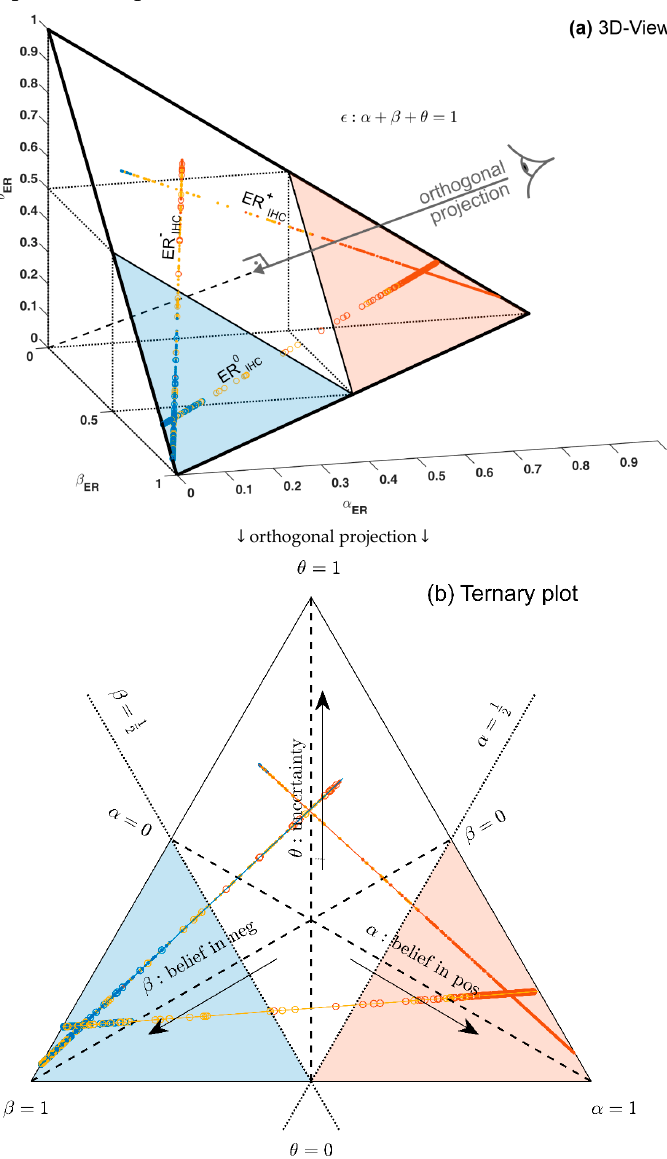
Figure 4. 3D plot and ternary plot of evidence for estrogen receptor status. ( a ) ordinary 3D plot. ( b ) ternary plot. Orthogonal projection of the 3D scatter plot (as indicated) in panel ( a ) yields the ternary version, panel ( b ). In each corner, one piece of evidence dominates and both others are zero, e.g., ( α = 1, β = 0, θ = 0 in the lower right corner). Note that the baseline of the ternary runs along the diagonal through the bottom plane of the 3D plot: along this bottom side, α runs from zero to 1 from left to right and β in reverse (right to left), hence sides of a ternary triangle do not represent usual ordinate axes, please refer to the tutorial (2.2.4). Midway points of triangle sides mark decision boundaries, e.g., α = β = 0.5 between positive and negative. Triangular areas contain definite results, either positive ( α ≥ 0.5, shaded red) or negative ones ( β ≥ 0.5, shaded blue). The kite-shaped area (white) represents undecided status according to DST. For each value of ER IHC see labeling (ER + , ER − , ER u ) evidence lies on a specific straight line due to mathematical reasons; samples with known IHC are shown as dots, samples with unknown IHC as circles. Coloring of samples according to ODDS method, not DST . Samples positive according to ODDS (red) may well lie within the undecided region according to IHC,